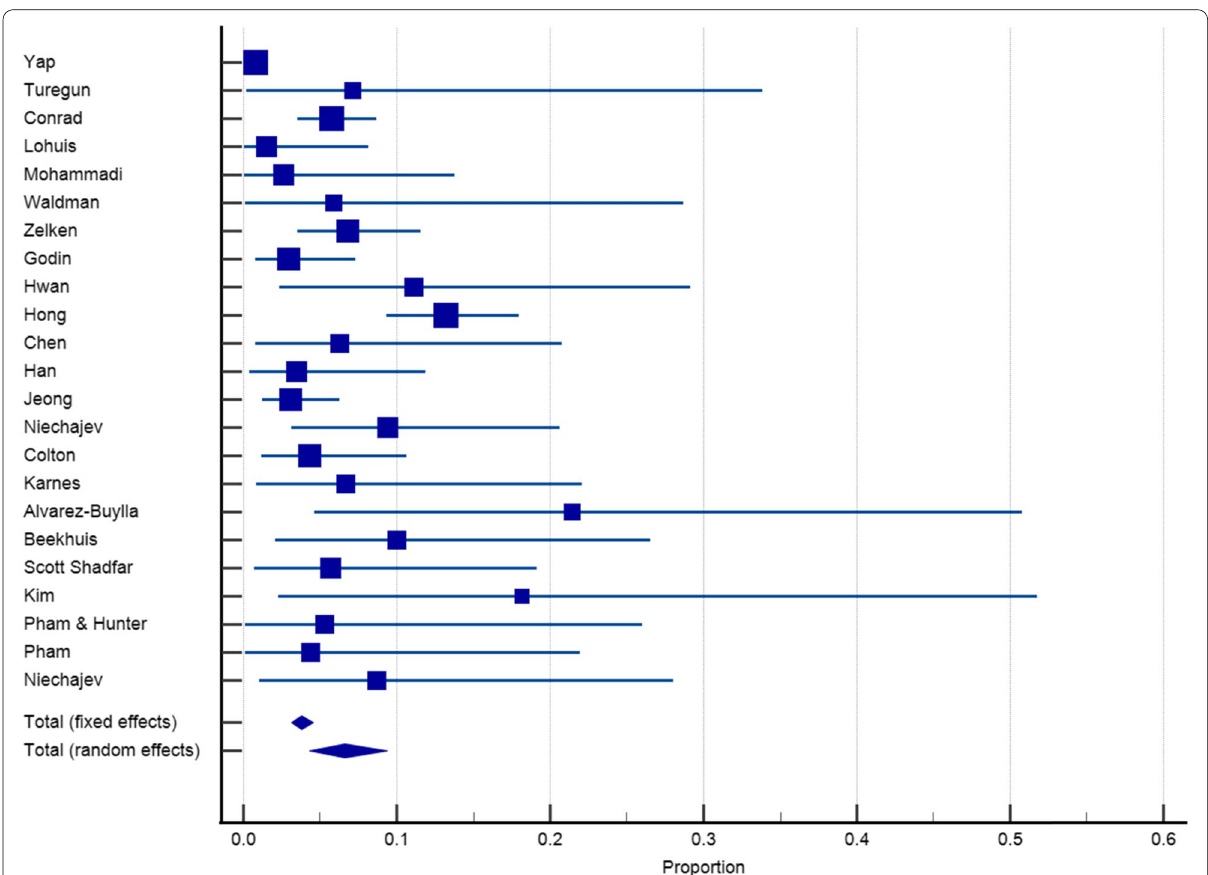
Fig. 8 Revision rates reported for synthetic materials in both fixed and random-effects